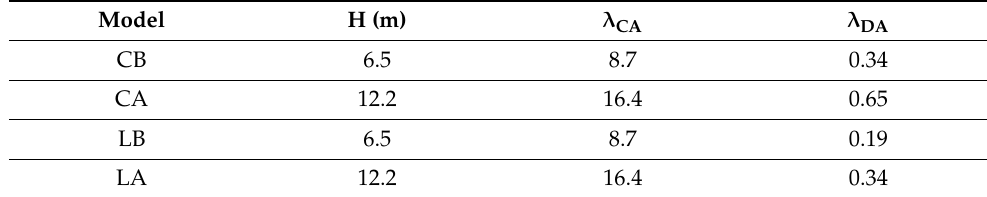
Table 1. Summary of slenderness parameters in rack structures